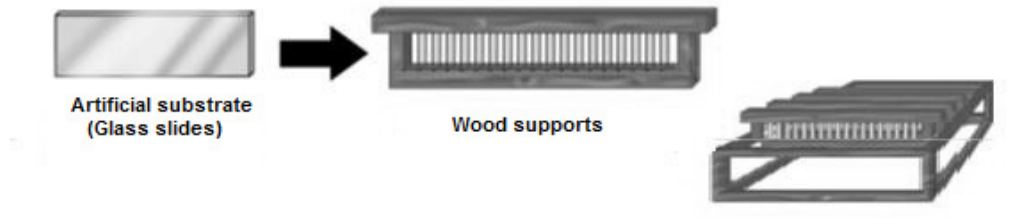
Figure 2. Artificial substrate used in the experiment (Adapted from Murakami,